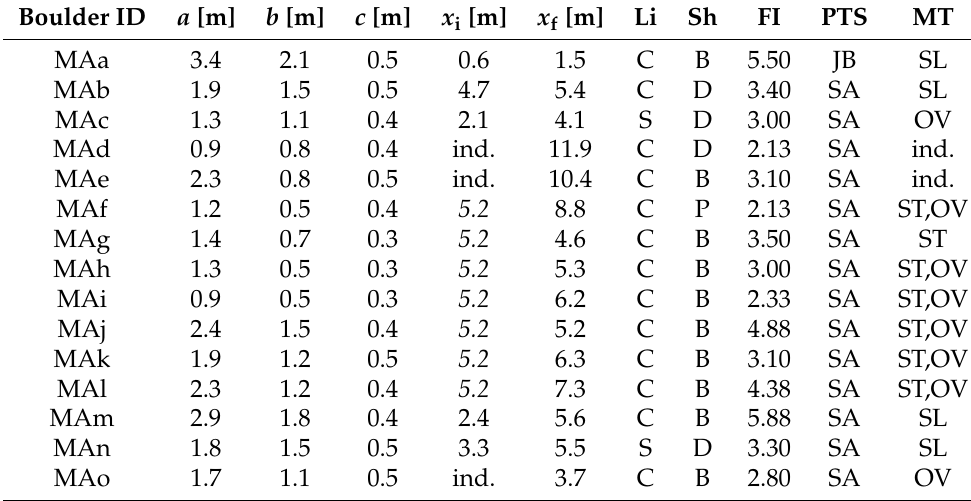
Figure A3. Mancaversa stretch of coast: ( a ) The boulder MAa and its initial position (blue dashed line) taken from the coastline. ( b ) The seven boulder group MAf-l; note that the unaltered rocky surfaces suggest the overturning of the boulders. ( c ) The sandstone boulder MAc and the neighbour, likely contemporary, rockfall. Table A8. Main features of the displaced boulders at the Mancaversa coast; see the caption of Table A2 for